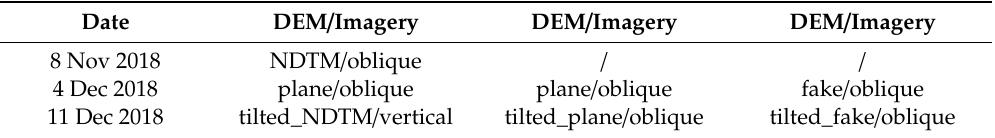
Table 1. Surveys of the Belca rockfall with information on DEMs and the type of images used in each